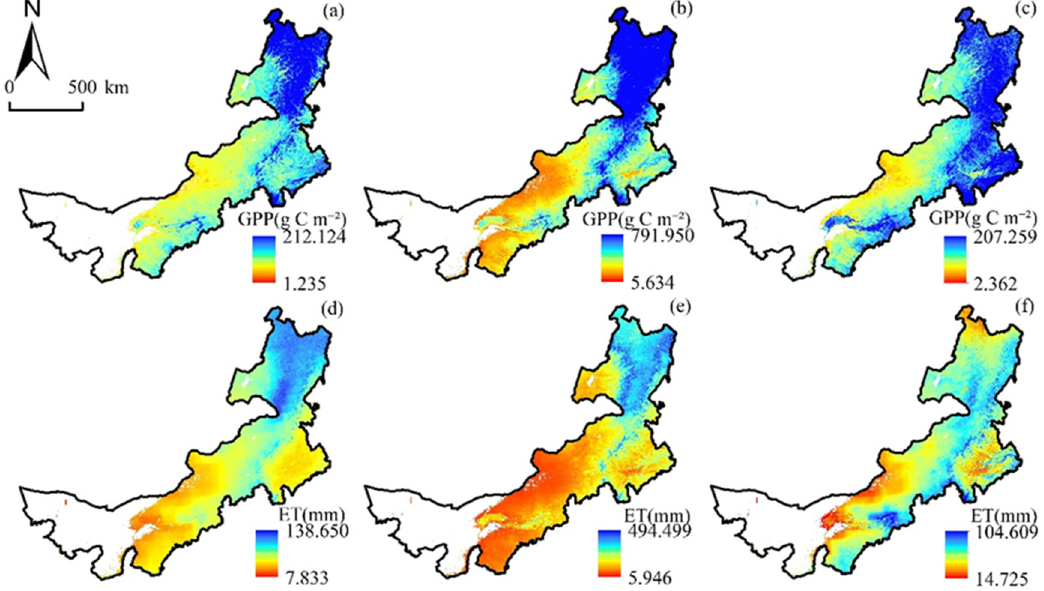
Figure 5. Distribution characteristics of the multi-year mean values of ET and GPP in Inner Mongolia. ( a – c ) GPP for spring, summer and autumn, ( d – f ) ET for spring, summer and autumn. 3.2.2. Characteristics of the Distribution, as Well as the General Trend of Change, of the Yearly Mean Value of